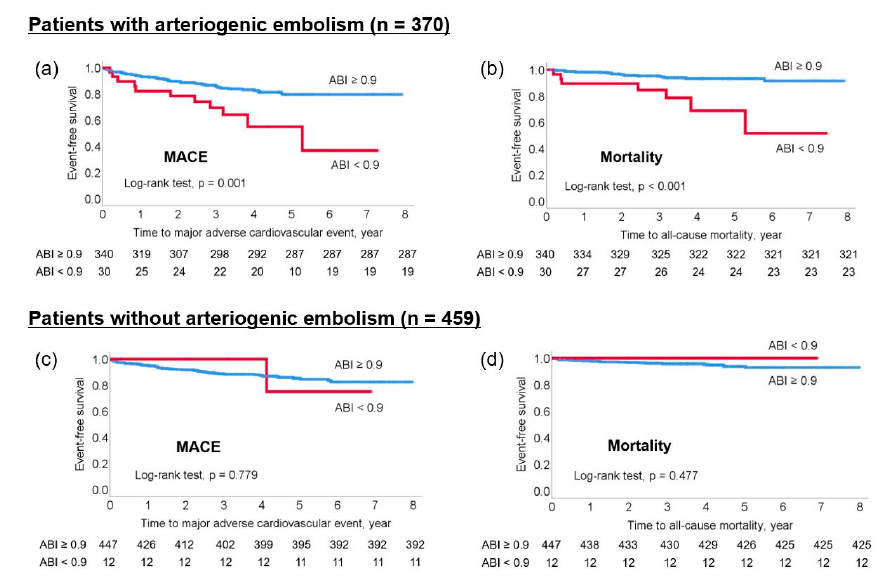
Figure 2. Kaplan–Meier survival analysis. ( a ) MACE and ( b ) all-cause mortality by low ABI in patients with arteriogenic embolism. ( c ) MACE and ( d ) all-cause mortality by low ABI in patients without arteriogenic embolism. ABI, ankle-brachial index; MACE, major adverse cardiovascular event.